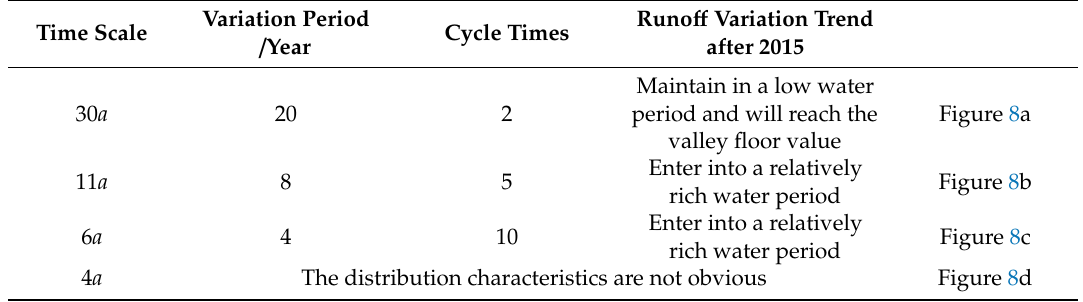
Table 3. Analysis results of runo ff time series di ff erent characteristic time scales.